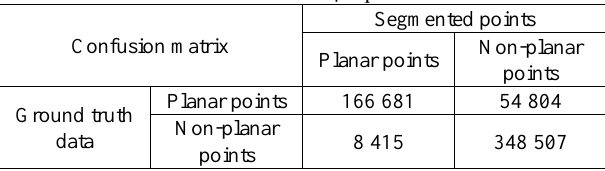
Table 6. Confusion matrix of the proposed method’s results